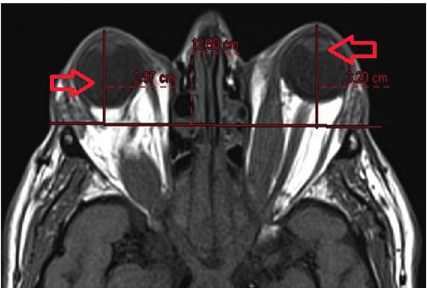
Figure 1: Exophthalmos measurement technique on MRI. The arrow shows the length from the foremost part of the cornea to the orbital apex.